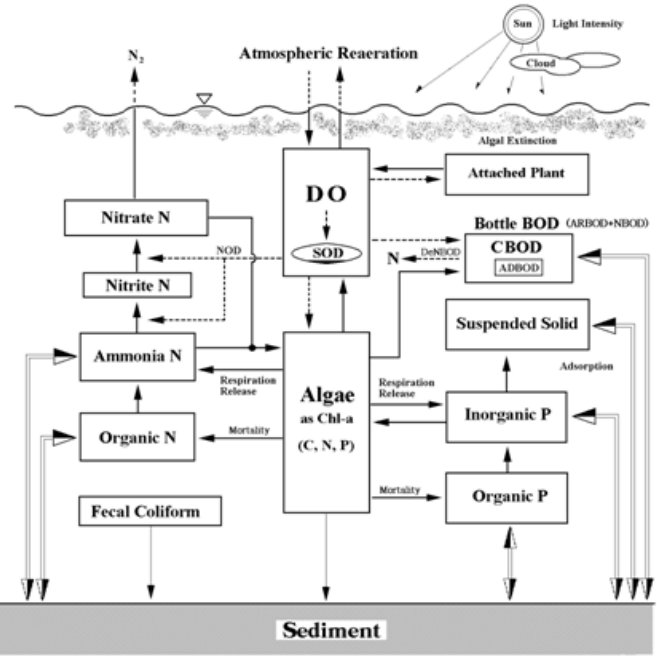
Figure 2. Major reaction mechanisms of the QUAL-MEV model.